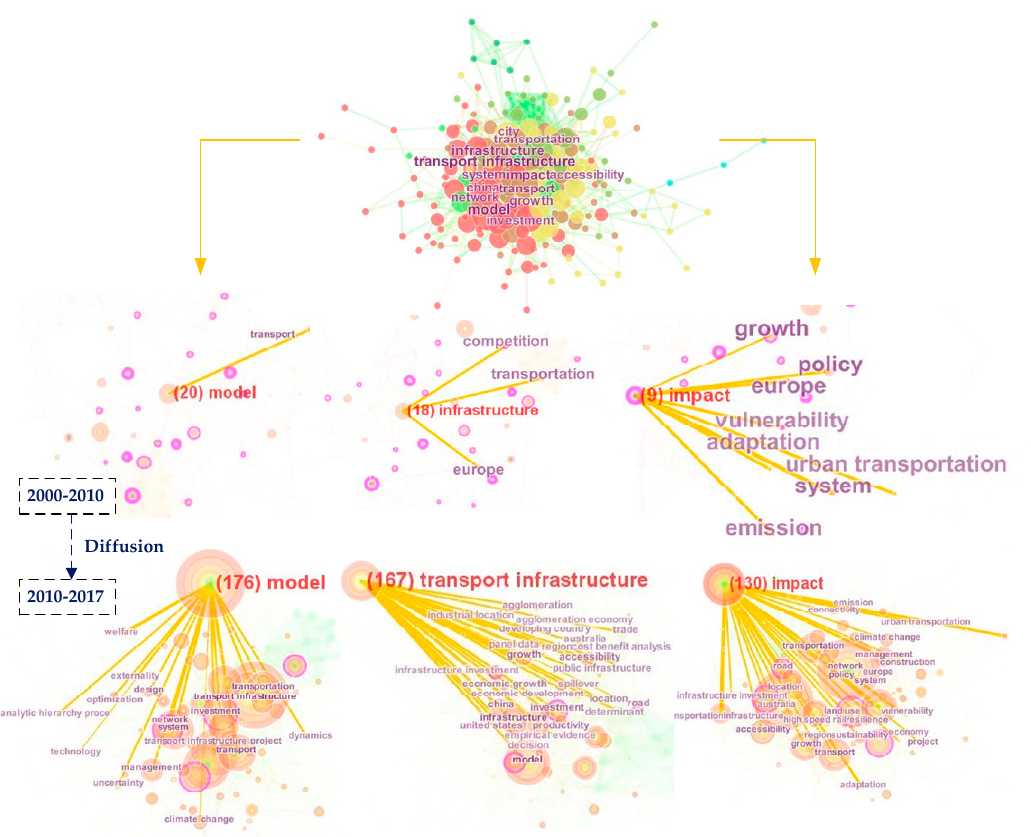
Figure 9. Keyword co-occurring network diffusion.